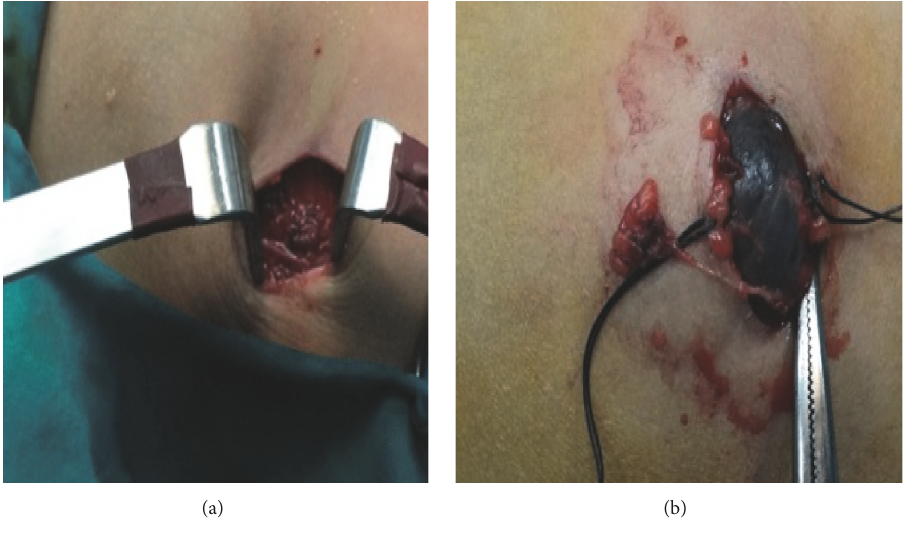
Figure 2: Procedure of lesion’s excision.